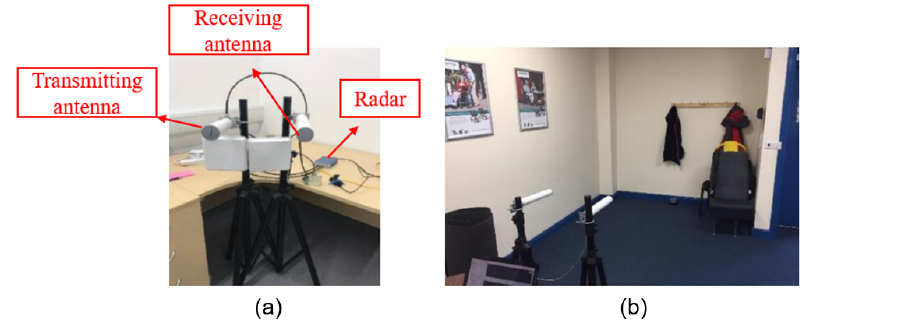
Figure 1. Radar configuration in the laboratory setup at the University of Glasgow ( a ), and in the West Cumbria Age UK centre ( b ).